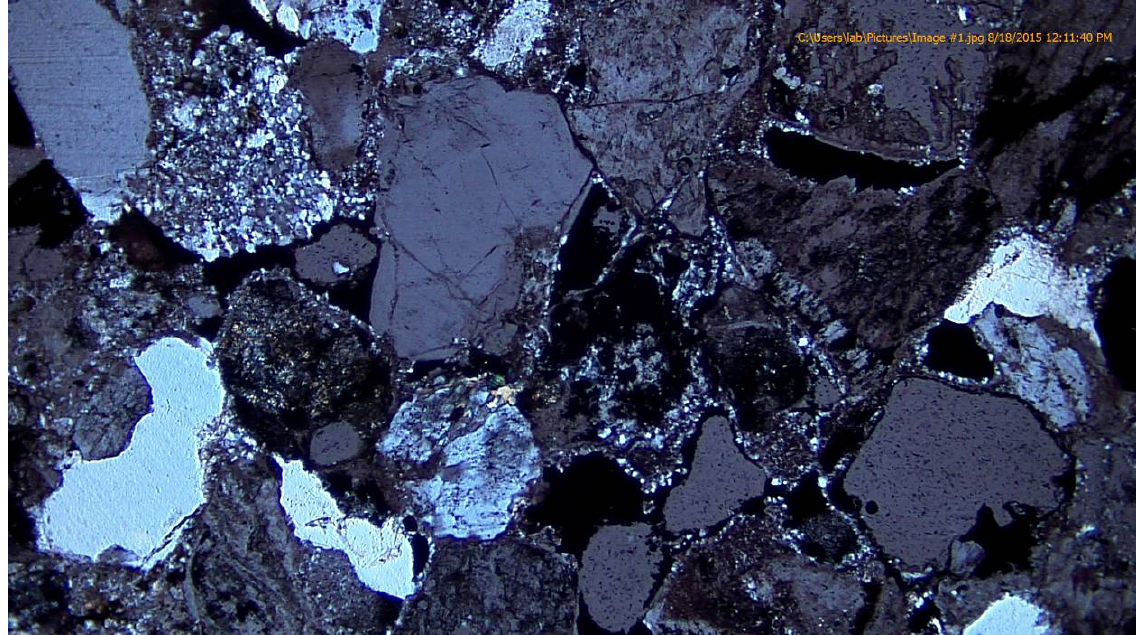
Figure 9. Petrographic image from Artefact 2, UlaanKhad (Ikh-78) in cross-polarized light at 40x